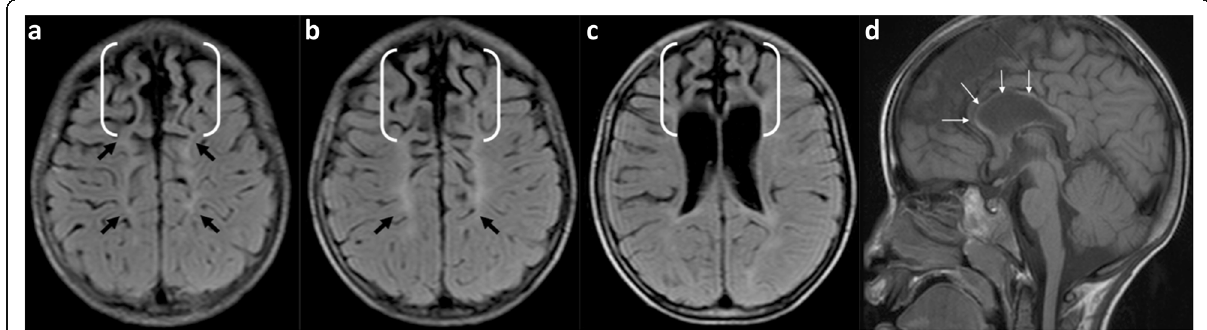
Fig. 9 a – d An 8-year and 10-month-old boy on sequential axial FLAIR images from superior to inferior ( a – c ), demonstrating the bilateral, symmetric, predominantly anterior inter-vascular watershed involvement, manifesting as frontal atrophy and underlying signal abnormality in continuity with the parasagittal volume loss and signal abnormality (black arrows). There is an expansion of the inter-hemispheric fissure anteriorly and prominent, deep, superior frontal sulci bilaterally (white brackets). The sagittal T1-weighted midline image ( d ) demonstrates associated corpus callosum volume loss predominantly affecting the rostrum, genu, and anterior body (thin arrows)